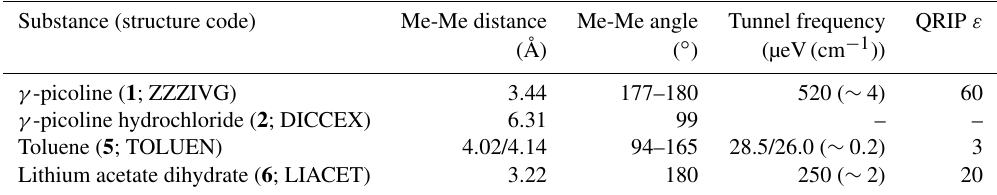
Table 3. Comparison of structural properties and QRIP. Methyl-methyl (Me-Me) distances were measured carbon to carbon, and angles between methyl groups were measured along the path from quaternary carbon via methyl carbon to the methyl carbon of the neighbor molecule (received from crystal structure data; Faber et al., 1999; Galigné et al., 1970; Ohms et al., 1985; van der Putten et al., 1992). Tunnel frequencies are from Prager and Heidemann (1997) and the QRIP signal enhancement factor ε from Icker et al. (2013). In addition to the name of the substance, the crystal structure code is given in parentheses.